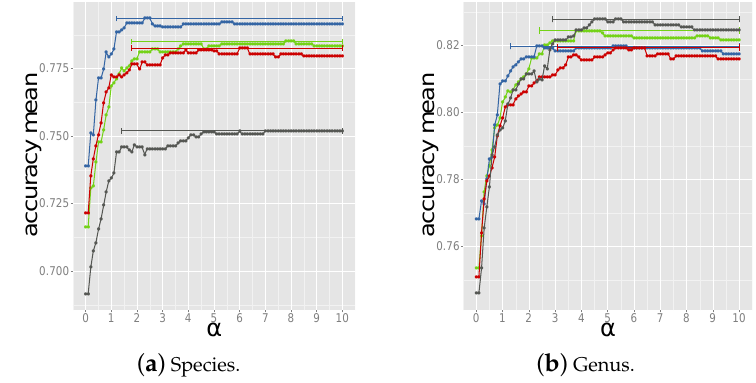
Figure 3. Accuracy vs. α values for prediction of species (a) and genus (b) in each tripartite set. Each dot represents the averaged accuracy over 100 bootstrap resamplings. The bars cover the range of α values for which the accuracy is 99% the highest